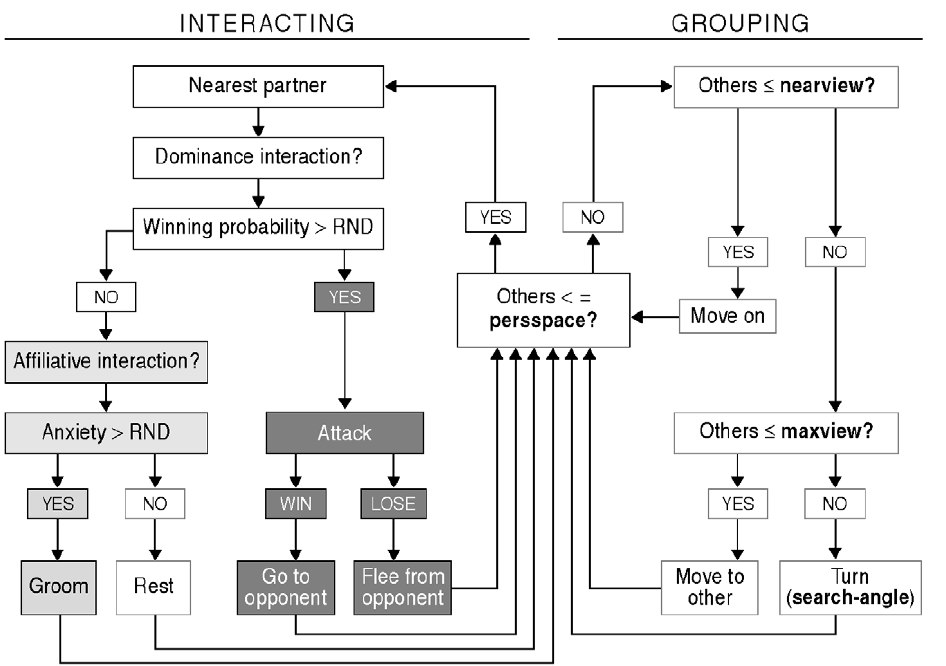
Figure 1. Rules of behavioural interaction. In light grey boxes the new rules of GrooFiWorld related to grooming are indicated. In white boxes the grouping rules, and in black boxes the rules for dominance interactions from DomWorld